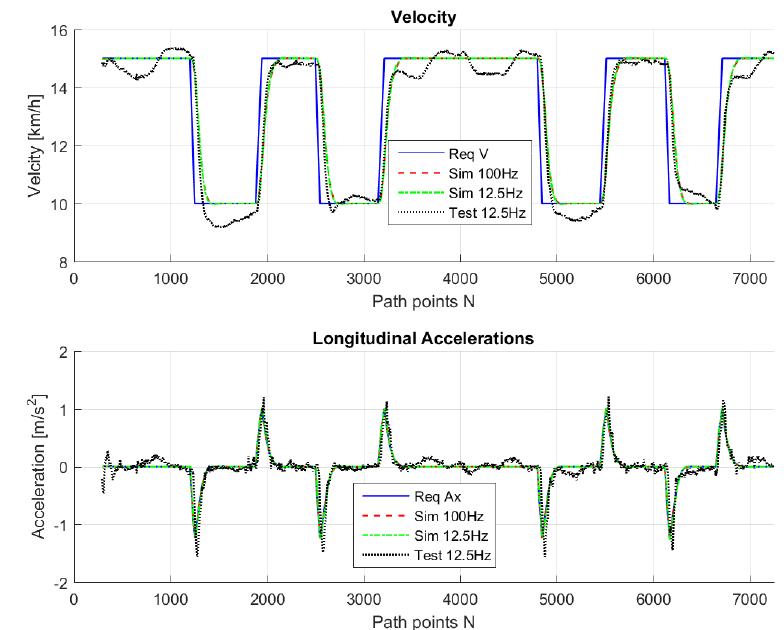
Figure 13. Longitudinal control output and resulting velocity for simulations and test drive.